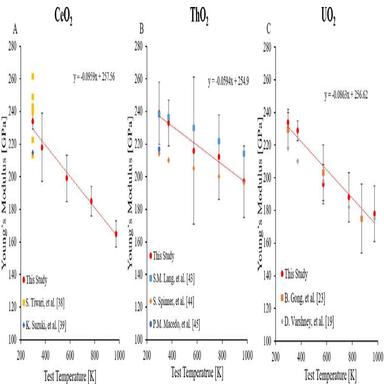
The Young's modulus of (A) CeO2, (B) ThO2, and (C) UO2 the oxide fluorite structure material over testing temperature as measured using nanoindentation. At each test temperature on each sample a minimum of 16 indents was performed with a 20 μm spacing.